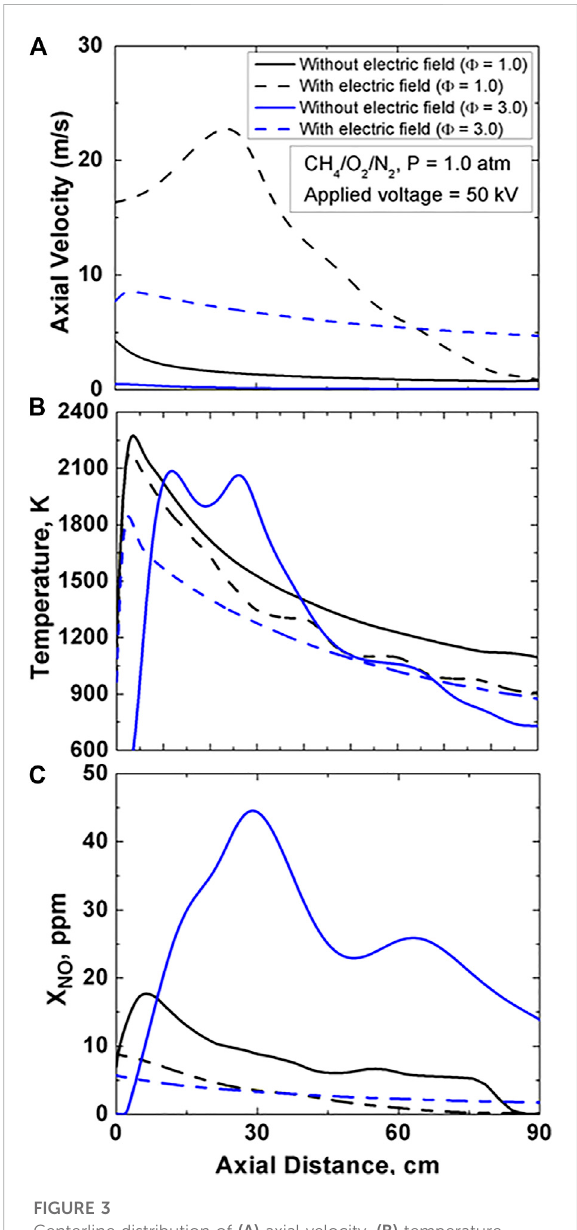
Centerline distribution of (A) axial velocity, (B) temperature, and (C) NO concentration with and without electric fi eld for